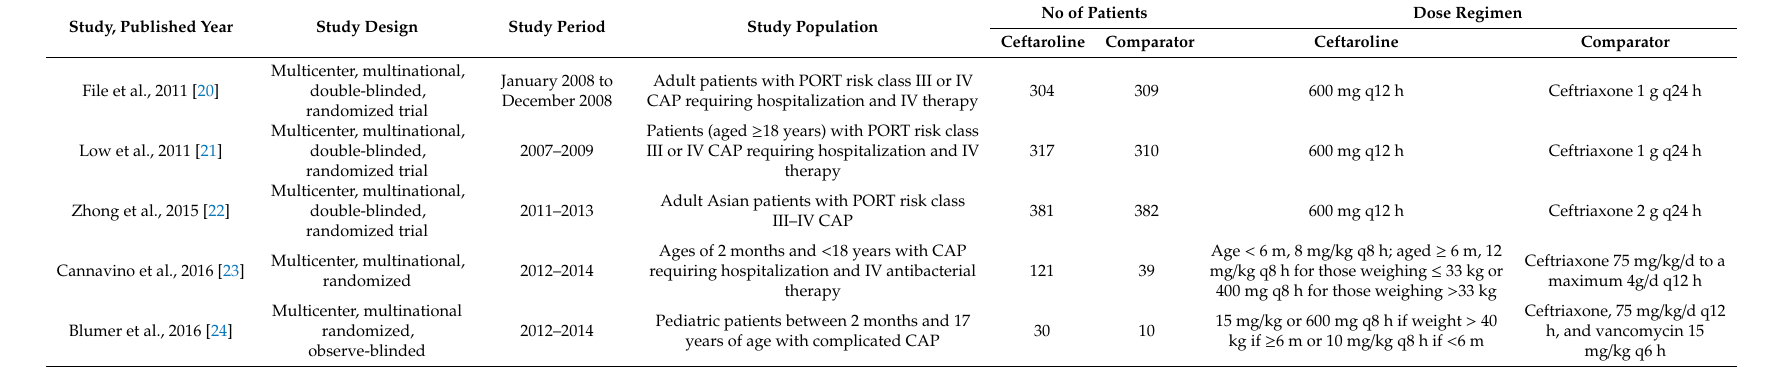
Table 1. Characteristics of included